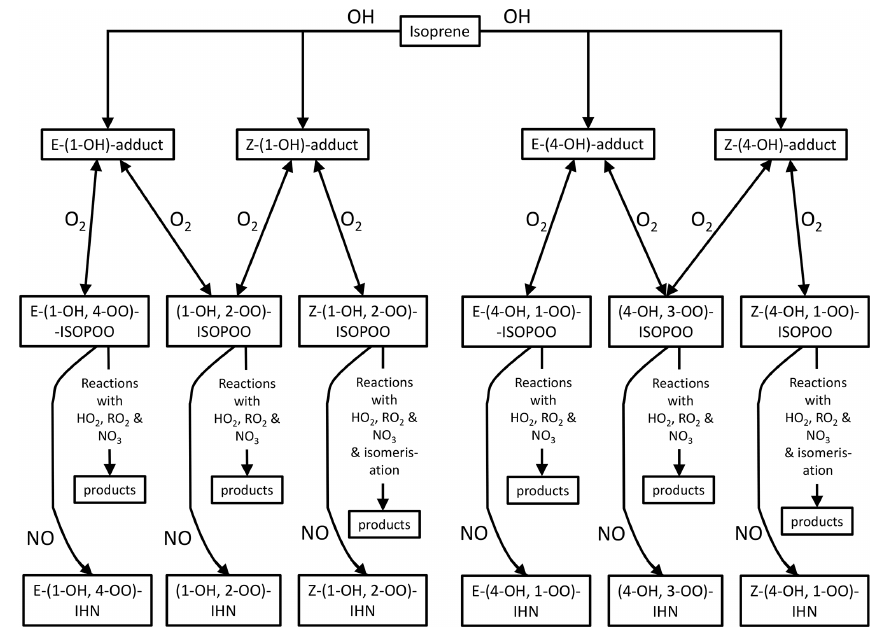
Figure 5. Schematic of the formation of the IHN following addition of OH to the C1 and C4 positions.